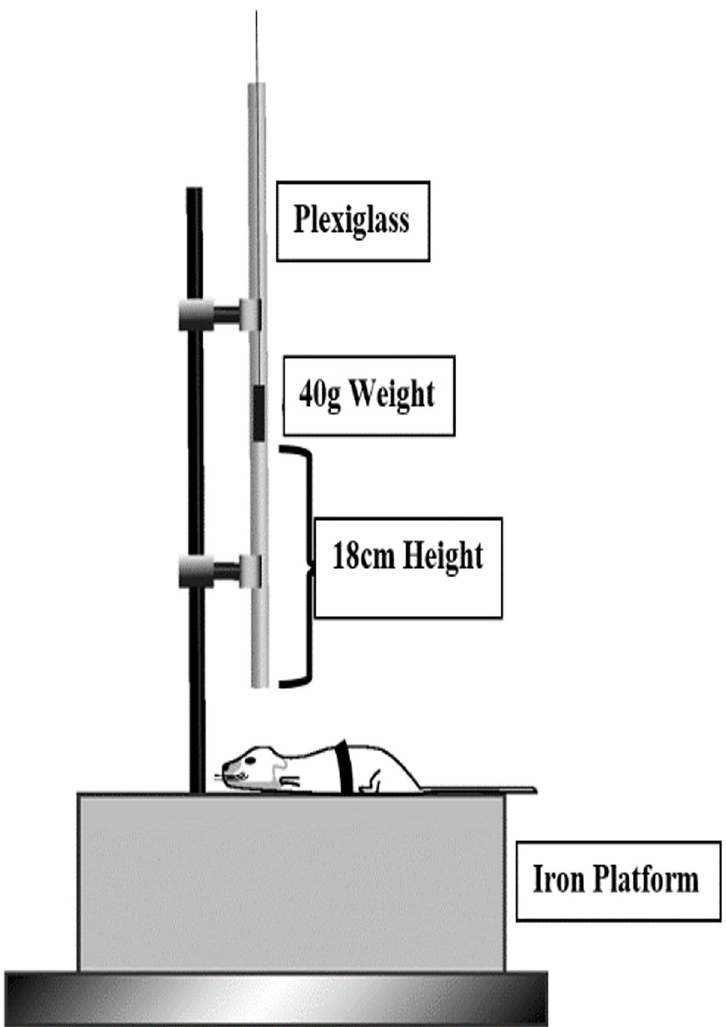
Fig 1. Scheme of TBI apparatus used to induce brain trauma. A 40 gram 10–mm diameter metal is fallen freely on a 50 cm plexiglass tube at 18 cm in height. Both, untreated and treated TBI mice were positioned on an iron platform without any head fixation, to induce a diffuse injury. The injury was repeated seven times over 14 days and 48 hours intervals between each